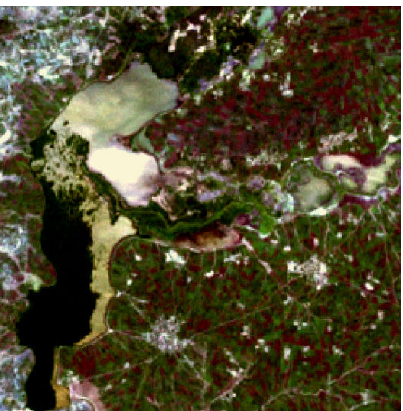
Figure 6. Changes from 1986 to 2002